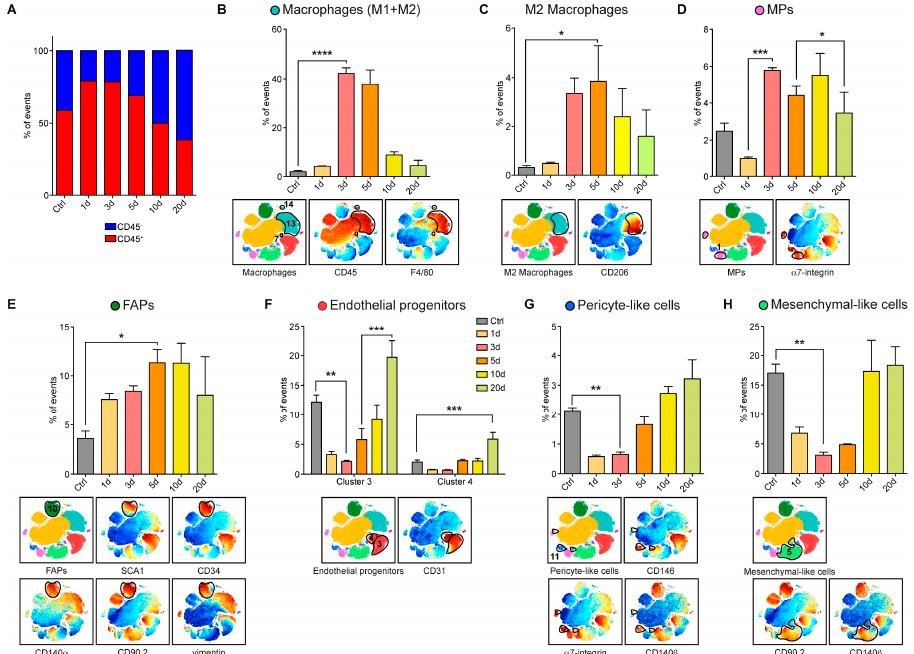
Figure 3. Characterization of the cell-population density rearrangements induced by CTX in the wt